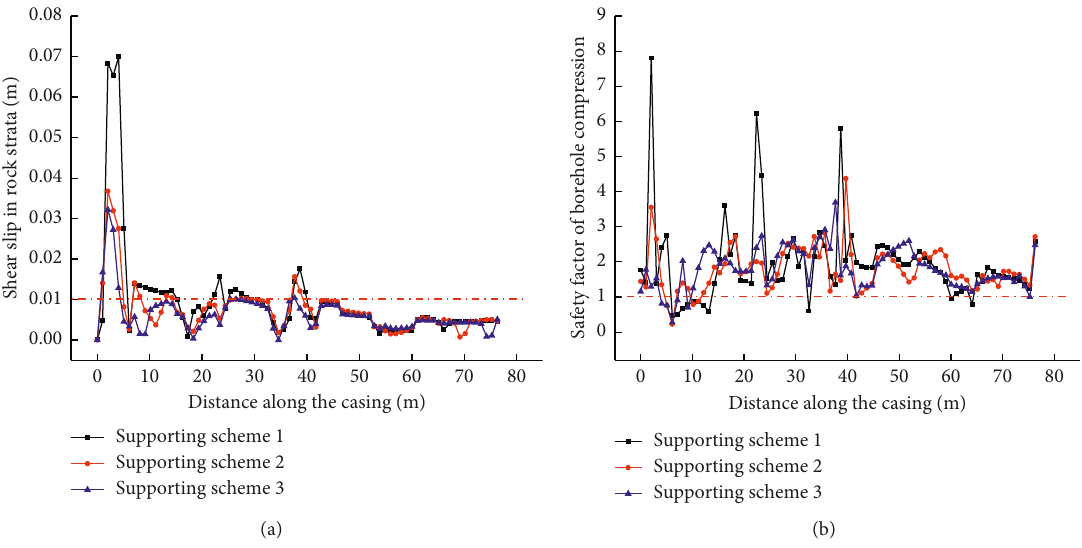
Figure 14: Effect of support scheme on the stability of the borehole. (a) Effect of support scheme on the shear stability of the borehole. (b) Effect of support scheme on the compressional stability of the